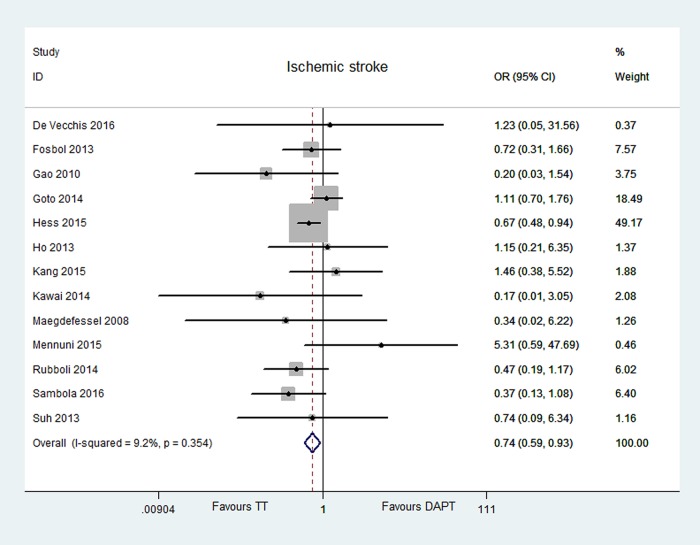
Forest plot of ischemic stroke in TT group vs DAPT group.